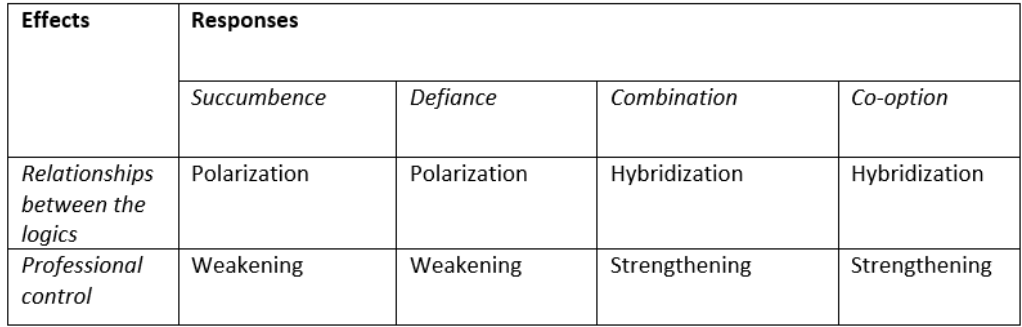
Table 2: Responses and their